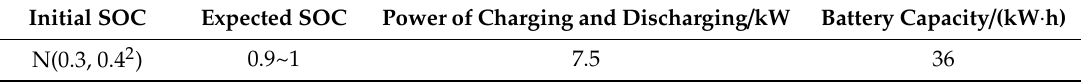
Table 1. Relevant parameters of EVs.